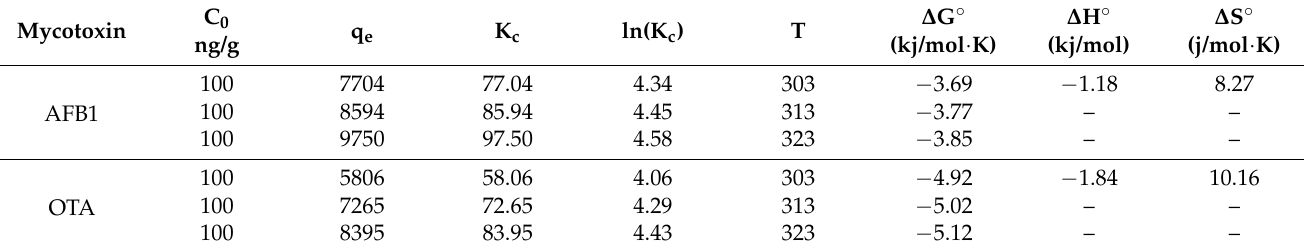
Table 5. Thermodynamic data for the adsorption of mycotoxins with the adsorbent (pH = 5, t = 5 h).